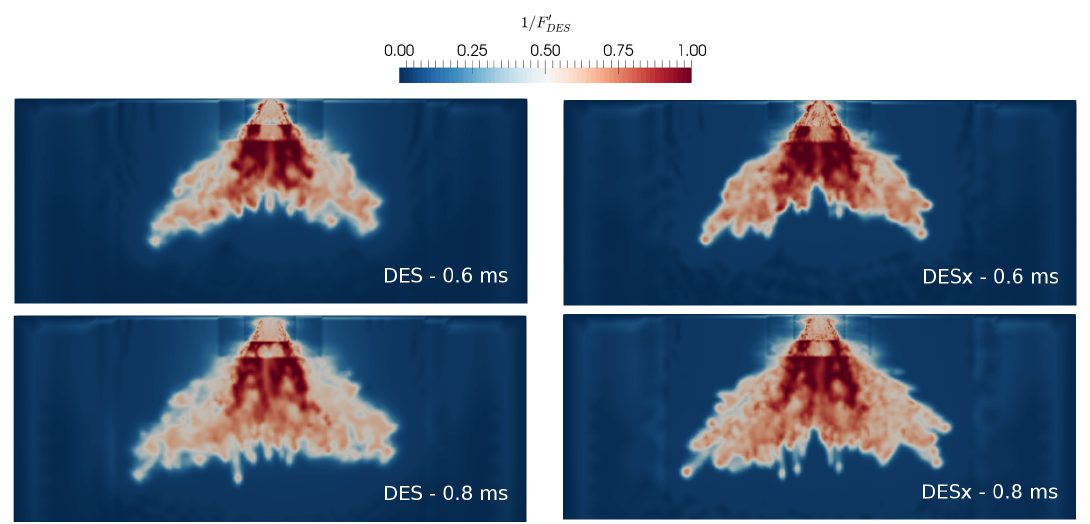
Figure 7. Snapshots of function 1/ F (cid:48) at t = 0.6 ms ASOI and t = 0.8 ms ASOI, for DES and DESx DES simulations, on a plane parallel to the injector